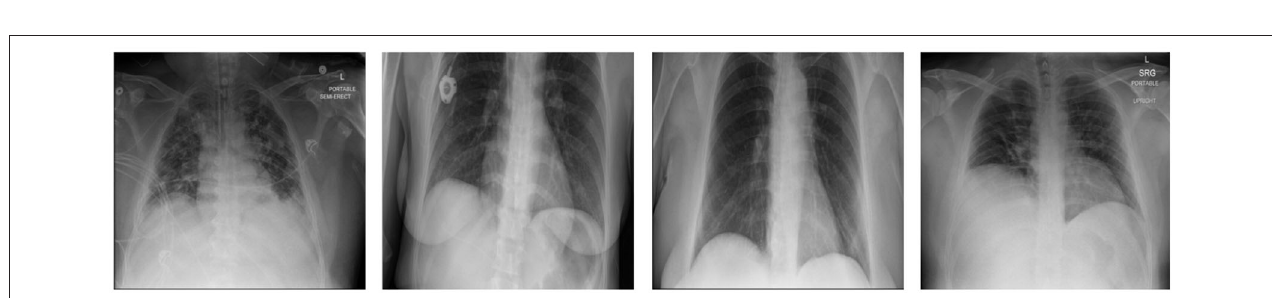
FIGURE 1 | Architecture of the proposed multi-scale encoder-decoder self-attention (MEDUSA) and how it can be incorporated to a deep neural network. The global component of MEDUSA is fed by the input data which its output is connected to different scales through the network via the multi-scale specific module. The scale box here refers to the bilinear interpolation operation on the output of σ ( A G ) function based on the width and height of the feature map of the corresponding convolutional block. Here, we have only drew three convolutional blocks but the network can have an arbitrary number of convolutional blocks.